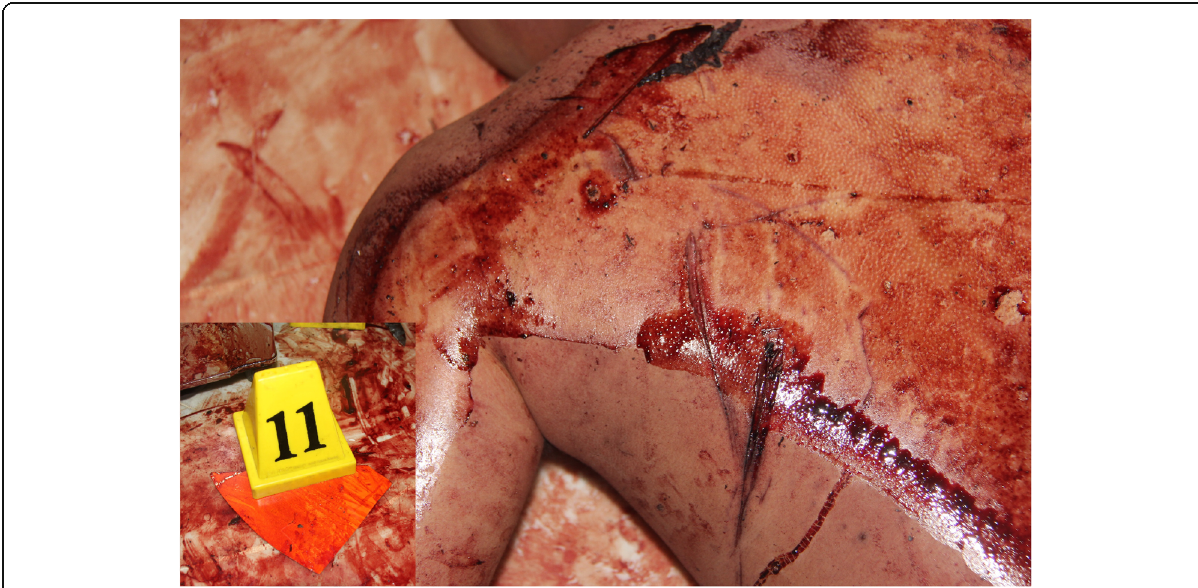
Fig. 6 Deep incised wounds on the back with marginal bruises were consistent with glass cuts. Inset: broken glass pieces were found on the floor beneath the